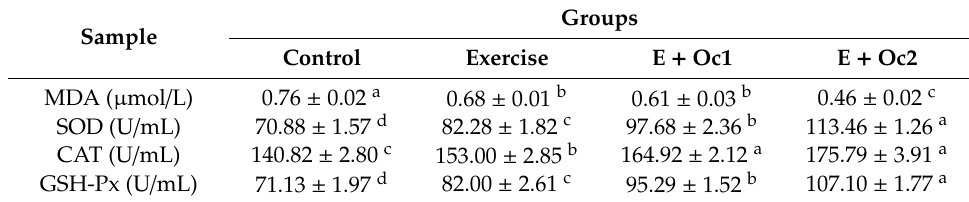
Table 3. Intramuscular activity of MDA, SOD, CAT, and GSH-Px across conditions.